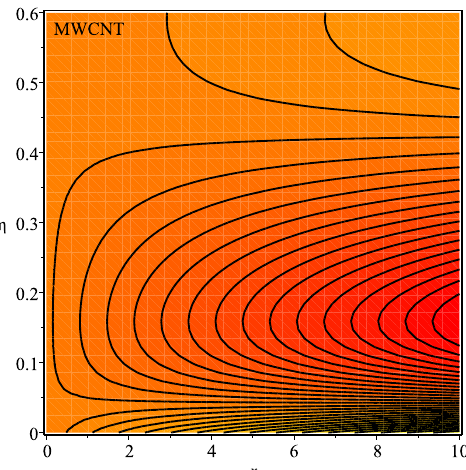
Figure 26. Repercussion of M egt = 2 with φ = 0.1, κ = 2, Ω = 1, ω = π /2, N = 10, Υ = 0.2, Pr = 100 on the